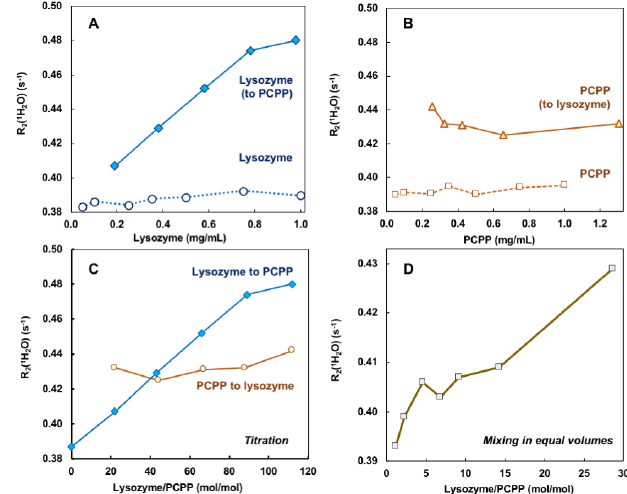
Figure 2. w NMR data for lysozyme–PCPP binding. ( A , B ) Concentration dependences of R 2 ( 1 H 2 O) for lysozyme ( A , spheres, dotted line), PCPP ( B , squares, dashed line), and changes observed upon addition of lysozyme to PCPP ( A , diamonds, solid line) and PCPP to Lysozyme ( B , triangles, solid line) obtained by titration (10 mg/mL titrant was added to 0.5 mg/mL analyte, PBS, pH 7.4); ( C ) w NMR lysozyme-to-PCPP titration data (blue line, diamonds) and PCPP-to-lysozyme titration data plotted against lysozyme-to-PCPP molar ratio; ( D ) w NMR data for complexes obtained by mixing lysozyme and PCPP in equal volumes (PBS, pH 7.4).